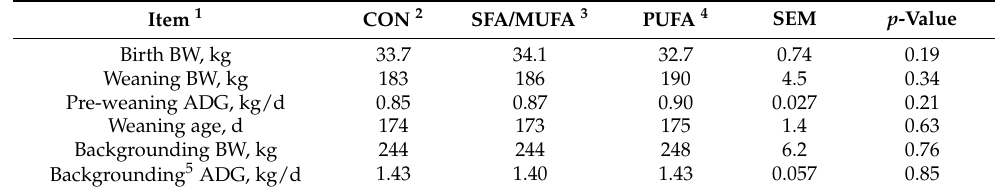
Table 10. Effects of supplementation for the last 82 ± 5 d of gestation of soybean hulls mixed with either whole-shelled corn (CON), Ca salts of saturated/monounsaturated fatty acids (SFA/MUFA), or Ca salts of polyunsaturated fatty acids (PUFA) on steer progeny growth performance during pre-weaning and backgrounding